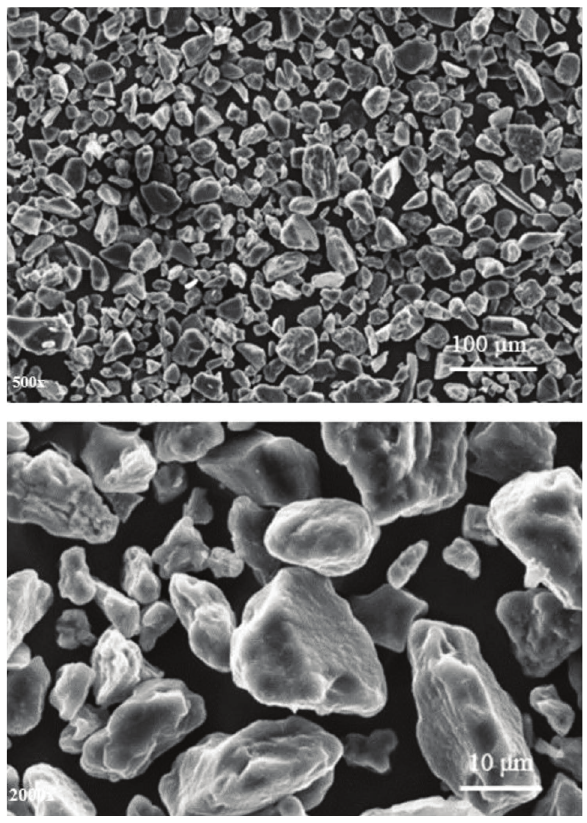
Fig. 2 – SEM micrographs showing the external morphology of the particulate matter, PM